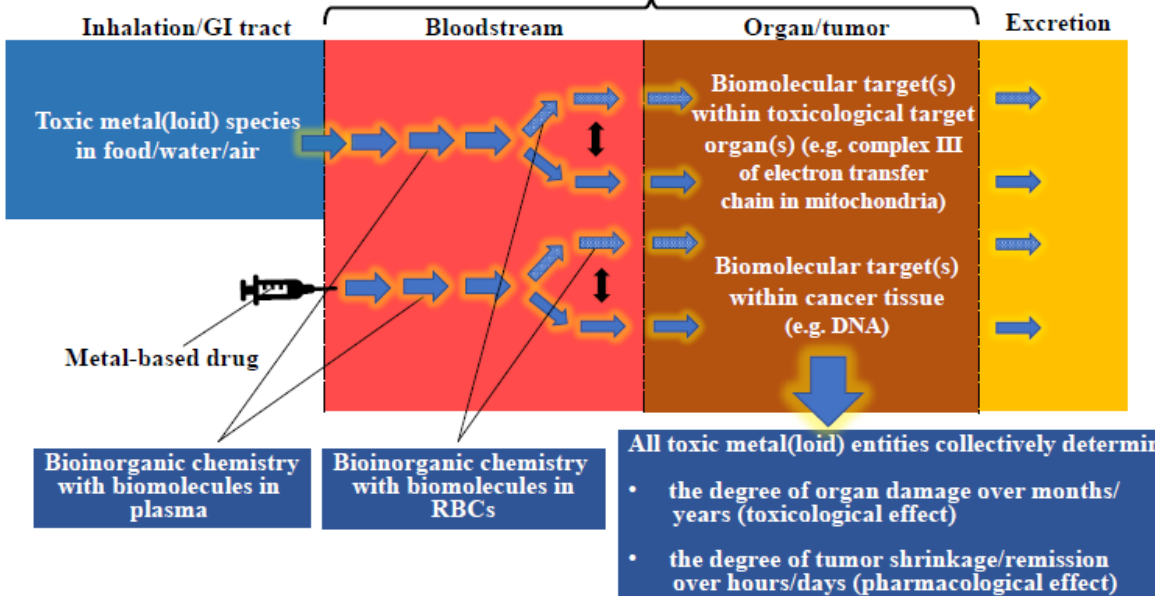
Figure 2. Conceptual relationship of bioinorganic processes in the bloodstream following ( a ) the chronic exposure of humans to a toxic metal(loid) species (toxicological effect) and ( b ) the intravenous administration by cancer patients of an anticancer metallodrug (pharmacological effect).